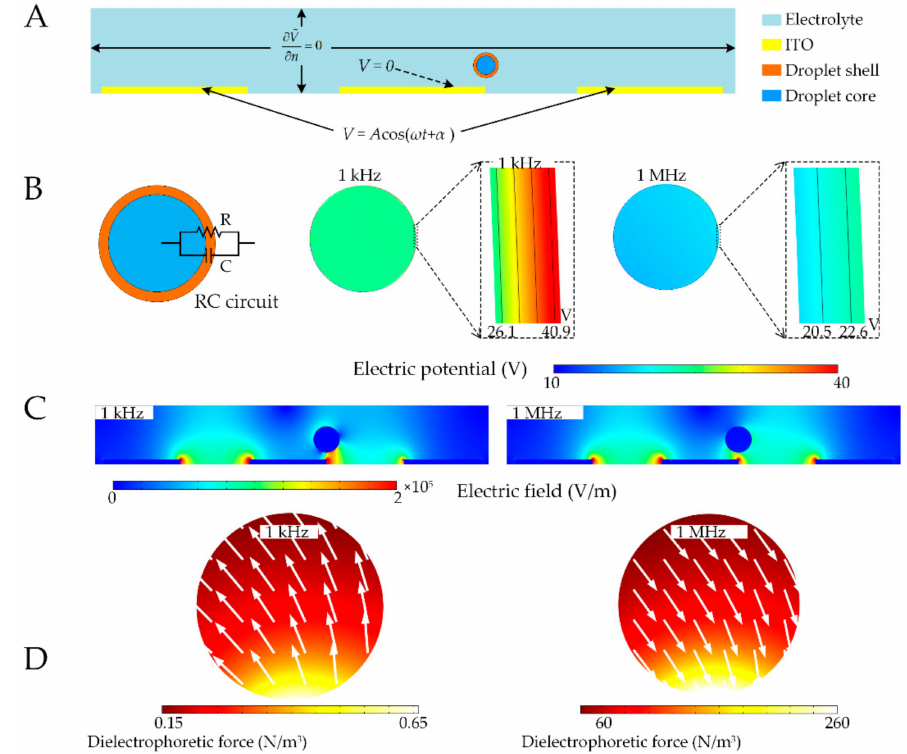
Figure 3. Simulation of dielectrophoresis (DEP0 response of double emulsion droplets. ( A ) The established geometrical model for numerical simulation; ( B ) Circuit model for current flow path through a droplet shell and the corresponding voltage drop across this shell at a voltage of 100 V; ( C ) Electric field distribution near the electrodes; ( D ) Dielectrophoretic force imposed on the